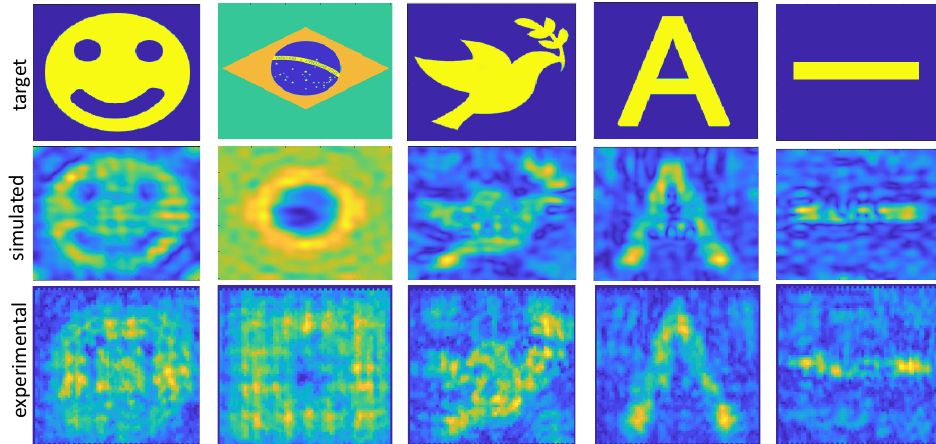
Figure 8. Amplitude slices obtained for different patterns, plotted using the function imagesc of Matlab. The first row is the target, the second one is the simulated slice, and the third row is the experimental measurement.